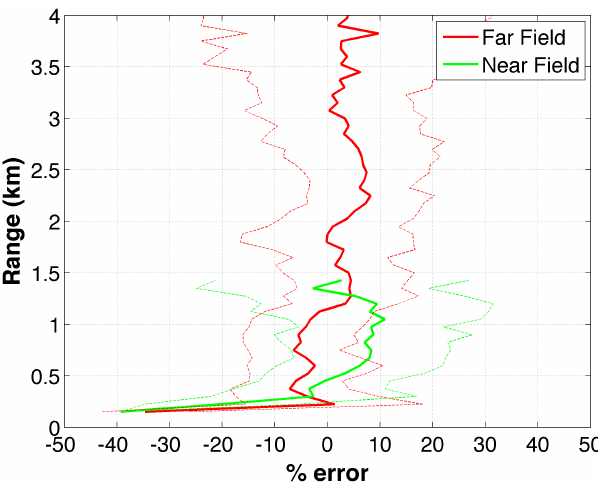
Figure 10. Sonde- to DIAL-measured water vapor in percent error. The mean (solid line) and SD (dashed line) percent errors are shown for all 45 sondes launched from 10 July through 19 August. The spatial resolution of the DIAL profiles are 150m below 2km and 600m above 2km. The DIAL profiles were processed with at 1min temporal resolution and averaged for 25min starting at the sonde launch